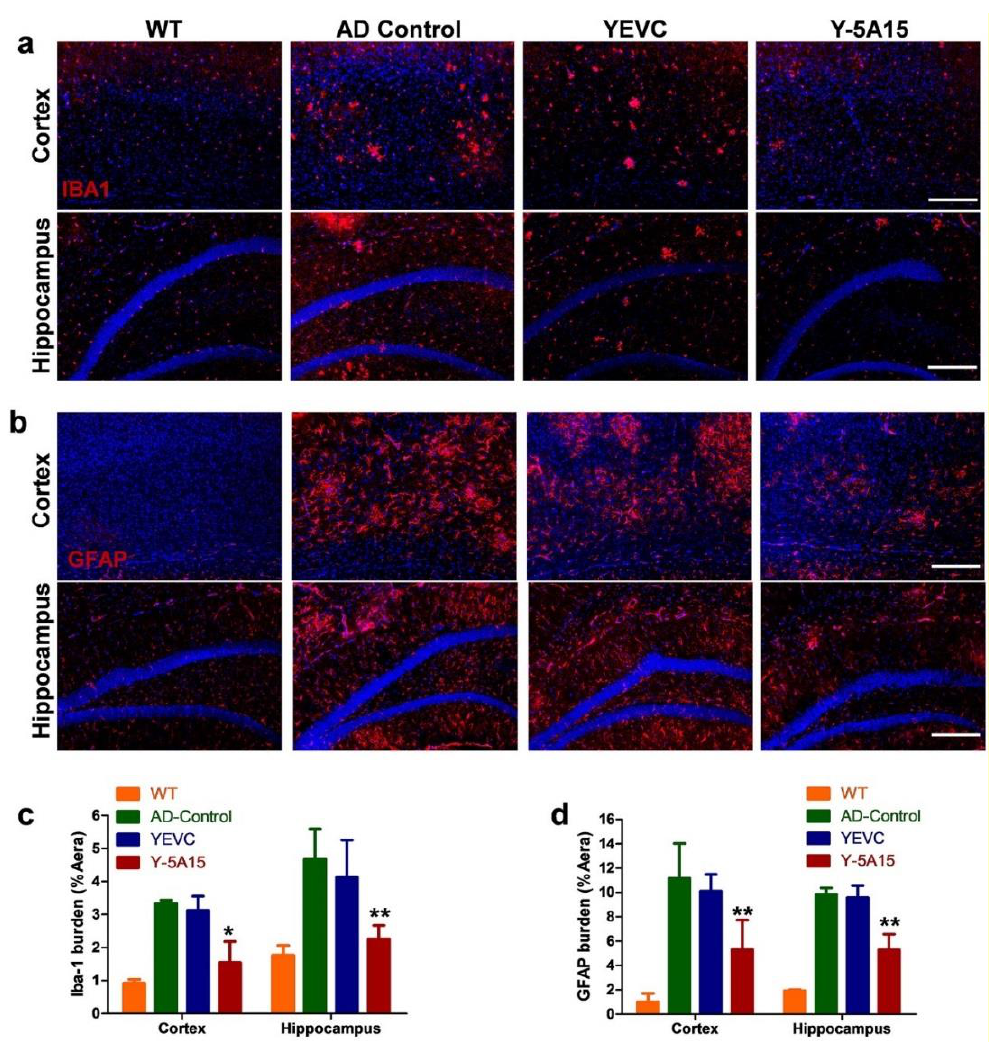
Figure 5. Y-5A15 vaccination decreased activated microglia and astrocytes in the hippocampus and cortex of APP / PS1 transgenic mice. ( a ) Representative fluorescence micrographs in the cortex and hippocampus of brain slices detected by staining Iba-1, and then the stained microglia were quantified using IpWin5 software ( c ). ( b ) Astrocytes in the cortex and hippocampus of brain slices were determined by staining GFAP, and then the stained astrocytes were quantified using IpWin5 software ( d ). Compared with AD control, * p < 0.05, ** p < 0.01, Student’s t -test, n = 6 mice per group. Scale bar is 200 μm.